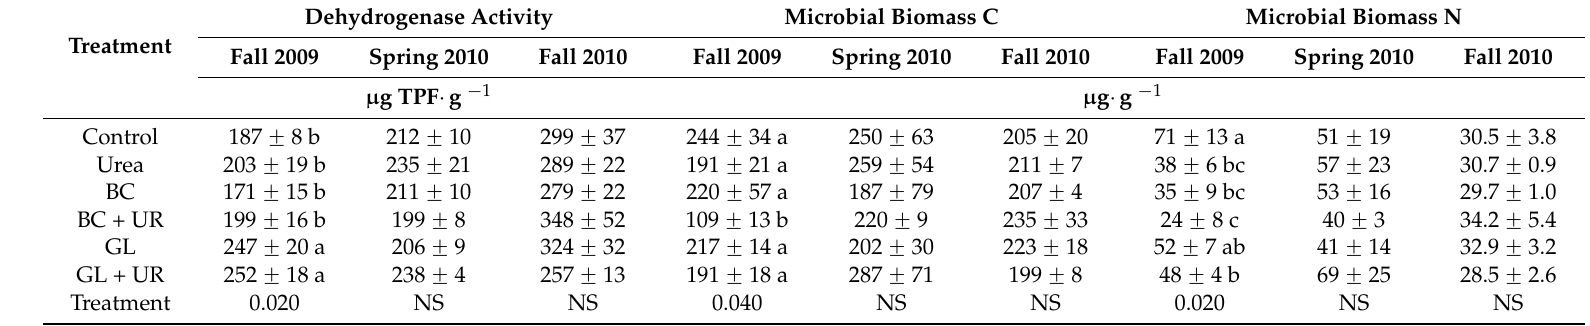
Means within a column sharing the same letter are not significantly different at p =